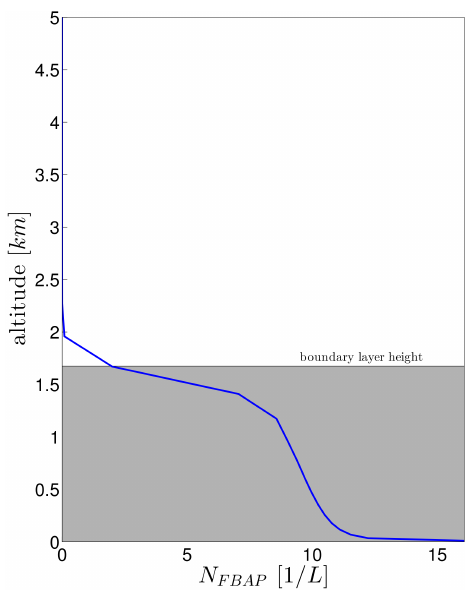
Figure 7. Exemplary vertical profile of simulated FBAP concentra- tion within and above the planetary boundary layer for Karlsruhe at 28 August 2010, 14:00UTC.